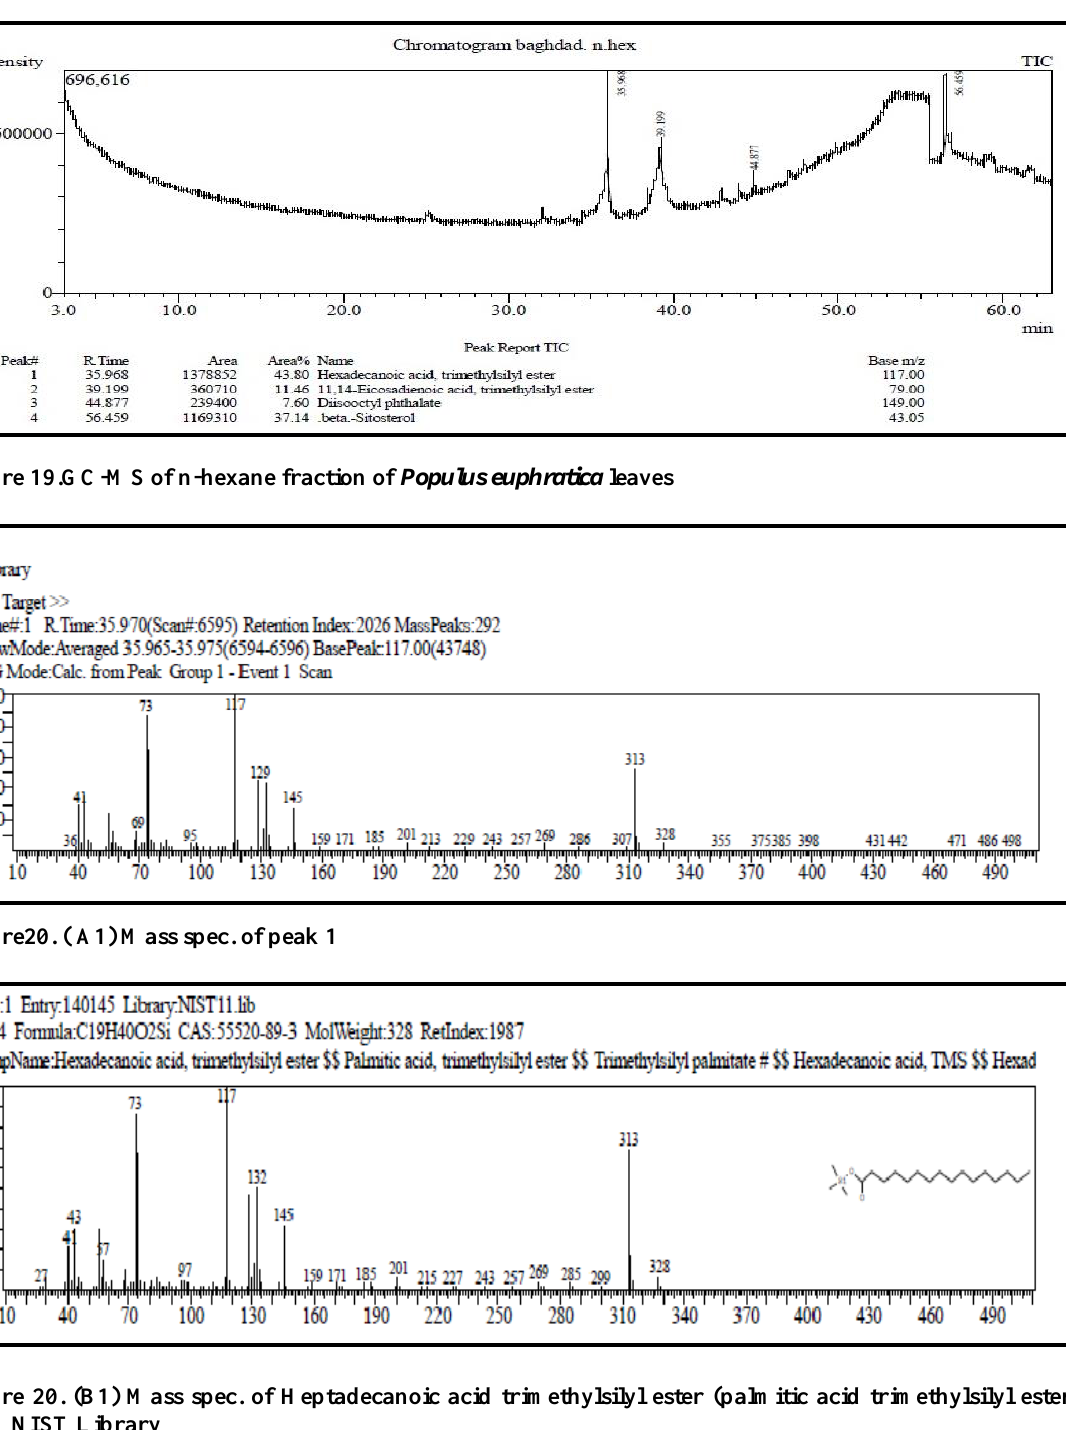
spec. between A1 and B1 it indicates the peak 1 is palmitic acid trimethylsilyl